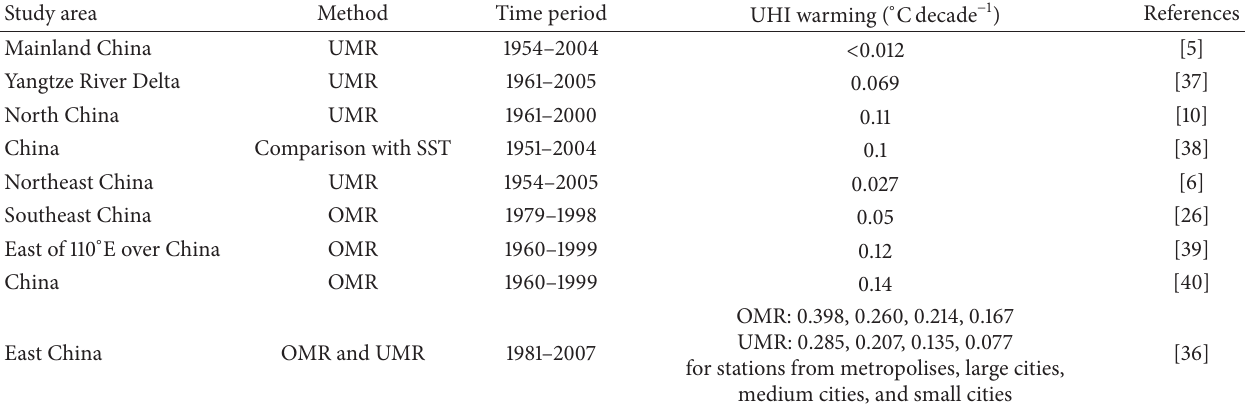
Table 1: Results of recent studies of the urban heat island effects in China at regional and national